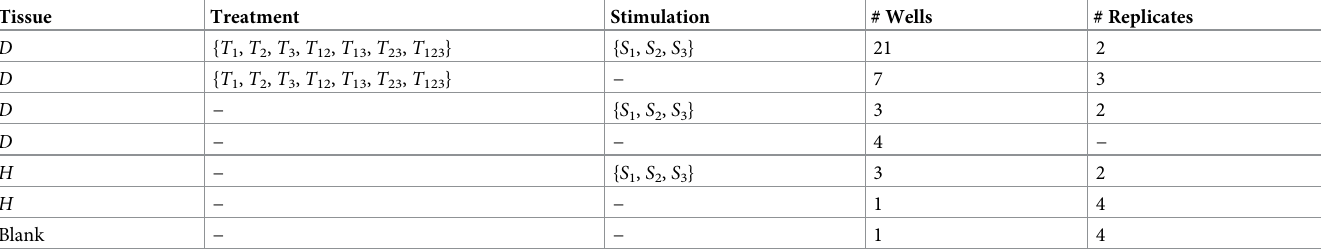
Table 3. Exhaustive experimental